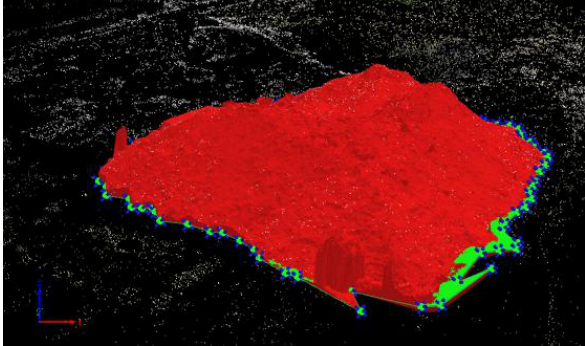
Figure 5. UAV Point cloud with Stockpile 3D